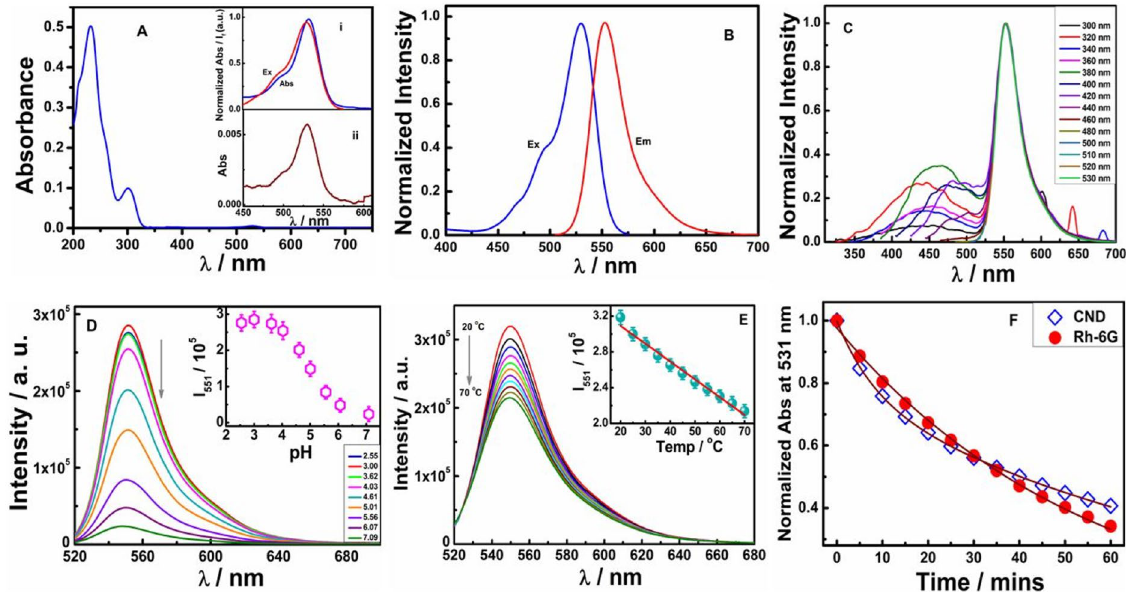
Figure 3. ( A ) UV/VIS absorption spectrum of CND (Inset (i) Normalized absorbance and excitation (ii) Magnified absorbance ~ 530 nm) ( B ) Excitation and emission spectrum of CND ( C ) Normalized PL of CND from 300 to 530 nm ( D ) pH dependent emission spectra of CND in aqueous solution ( E ) Temperature dependent emission spectra of CND in PBS buffer solution and ( F ) Normalized degradation plot of CND and Rh6G in ethanol. (I 551 stands for fluorescence intensity at 551 nm and error limits for photo-physical experiments is ≤